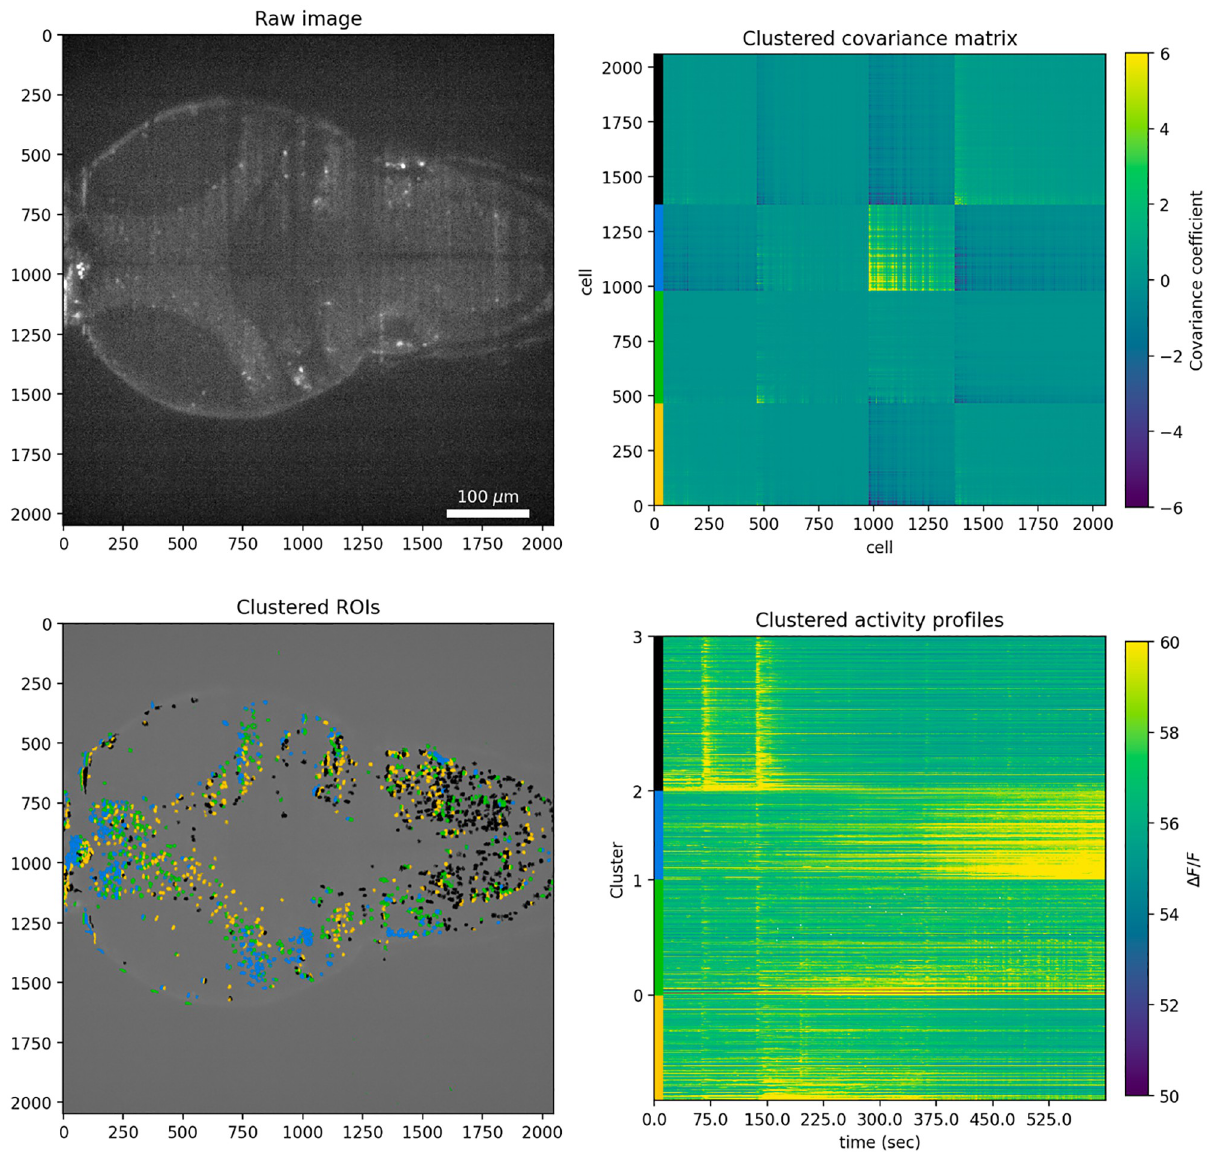
Fig 5. Analysis pipeline for Suite2P-processed data with k-means clustering for k = 4 (four clusters). Top left: first raw image of the timeseries imaging data. Top right: k-means-clustered covariance matrix of ROIs activity. Color bars on the left correspond to different clusters. Bottom left: Spatial distribution of Suite2P neuron ROIs colored according to covariance matrix clustering. Colors indicate cluster membership according to k- means clustering of the covariance matrix. Bottom right: Activity traces for each Suite2P ROI. Color bars on the left indicate cluster membership according to k-means clustering of the covariance